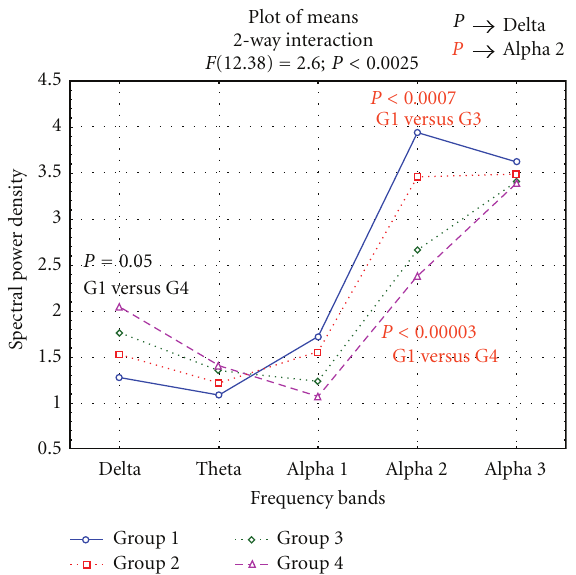
Figure 1: Statistical ANOVA interaction among groups, factor and relative band power (delta, theta, alpha1, alpha2, and alpha3). In the diagram the di ff erence in delta and alpha2 power among groups is also indicated, based on Duncan’s post hoc testing. G1, group